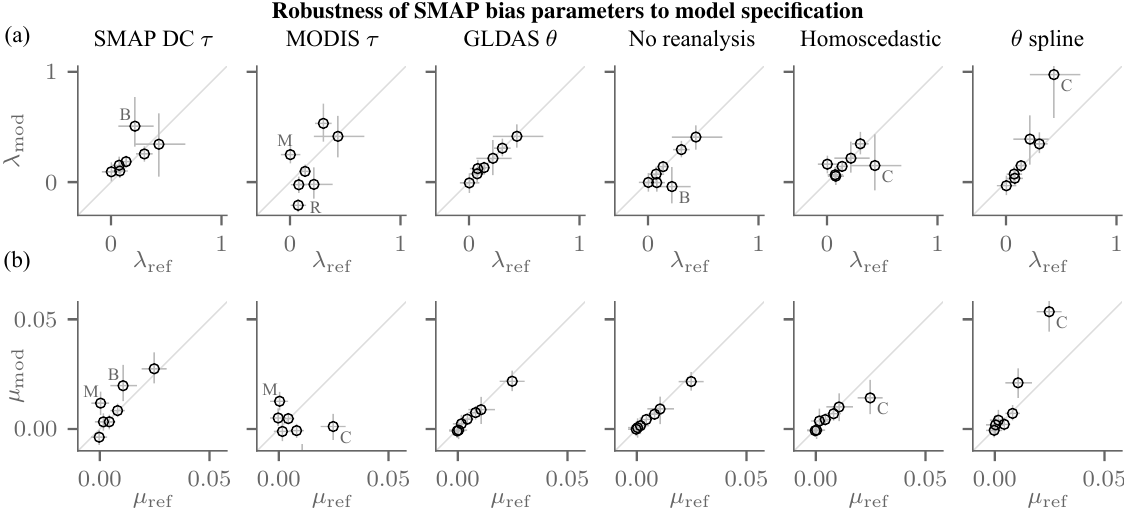
− 3 )) parameters. Each panel compares the reference Figure 6. Robustness quantified by changes in the estimated λ ( a , (–)) and µ ( b , (m 3 m estimates on the horizontal axis (median: marker, lines: 10%–90% posterior probability interval) to those obtained with the modified model on the vertical axis (cf. Sect. 4.1.2). The most prominent outliers are annotated – B: Bell Ville, C: Carman, M: Monte Buey, R: REMEDHUS.